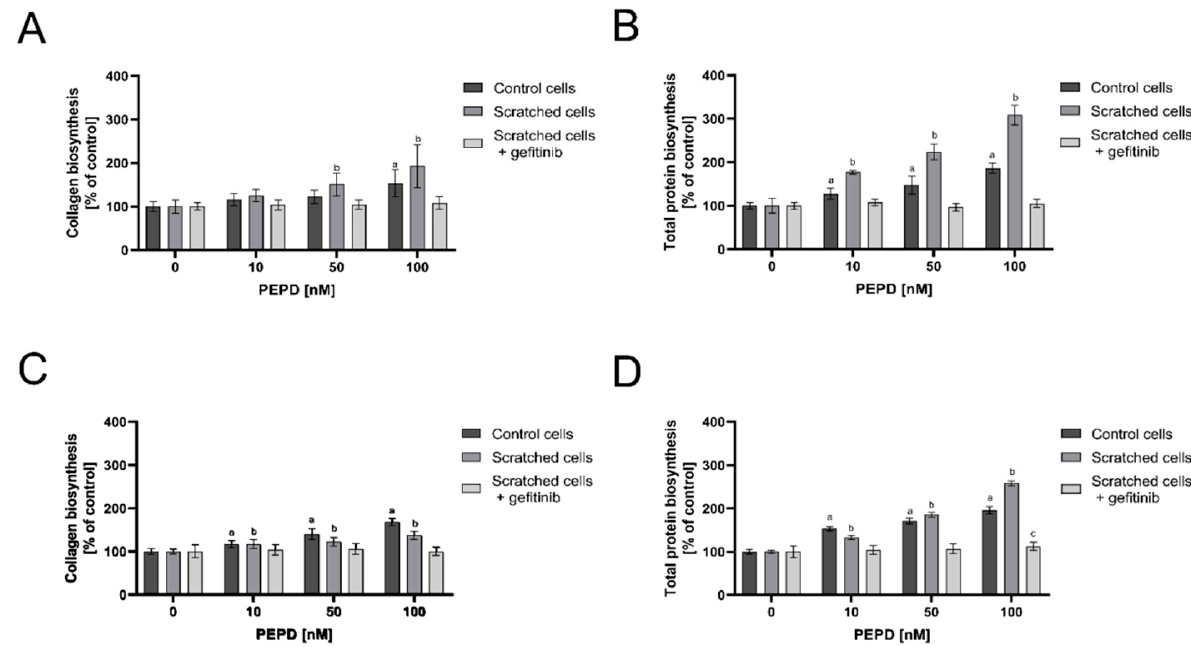
Figure 5. Extracellular PEPD activated collagen and total protein biosynthesis in control and “scratched” fibroblast models. Collagen biosynthesis ( A , C ) and total protein biosynthesis ( B , D ) in PEPD-treated fibroblasts (1–100 nM) in the presence and absence of EGFR inhibitor (Gefitinib, 0 and 45 µ M pretreated cells for 2 h) after 24 and 48 h incubation, respectively. The values were presented as a percent of control cells (0 nM of PEPD). Mean values ± SD of three experiments done in replicates is presented. The results are significant at a, b, c < 0.05, and are marked as a vs. control (0 nM of PEPD) of control cells, b vs. control (0 nM of PEPD) of scratched cells, c vs. control (0 nM of PEPD) of scratched cells incubated with gefitinib, respectively.